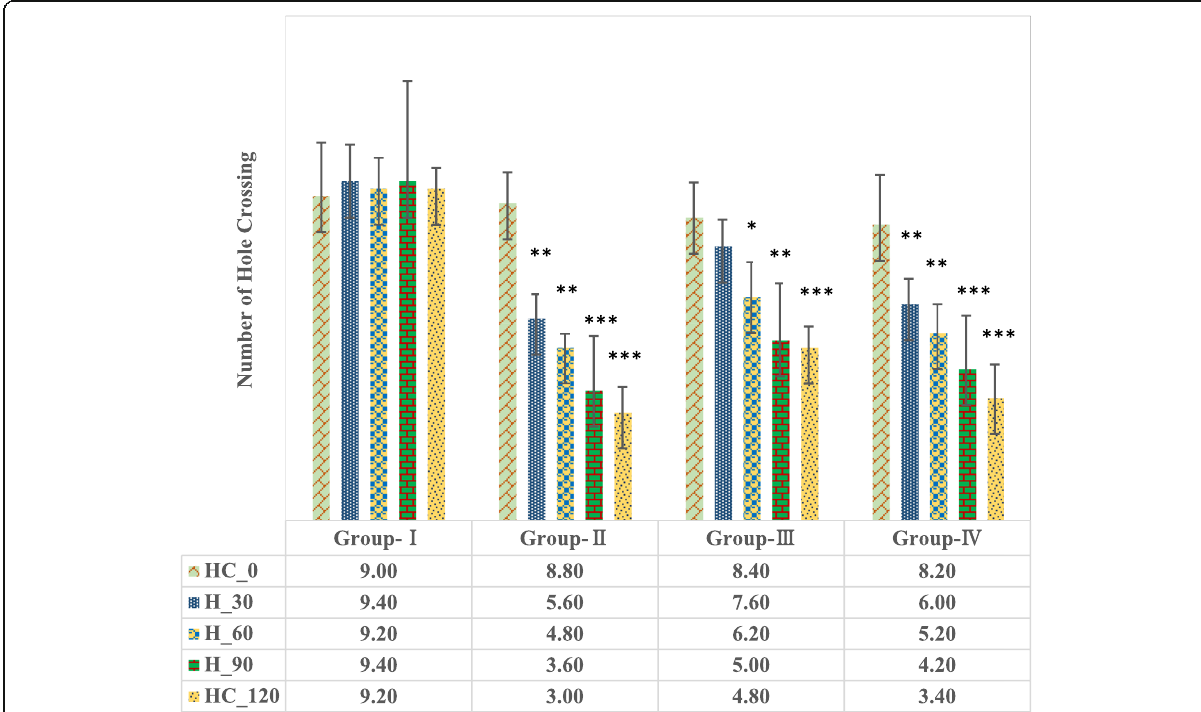
Fig. 5 Effect of Psidium guajava Linn leaves extract on number of hole crossing in hole cross model. Group I = control group, group II = positive control group, group III = Psidium guajava Linn low strength group, group IV = Psidium guajava Linn high strength group. * p < 0.05, ** p < 0.01, *** p < 0.001 vs group I. HC_0 = number of hole crossing at 0 min after treatment; HC_30 = number of hole crossing after 30 min of treatment; HC_60 = number of hole crossing after 60 min of treatment; HC_90 = number of hole crossing after 90 min of treatment; HC_120 = number of hole crossing after 120 min of